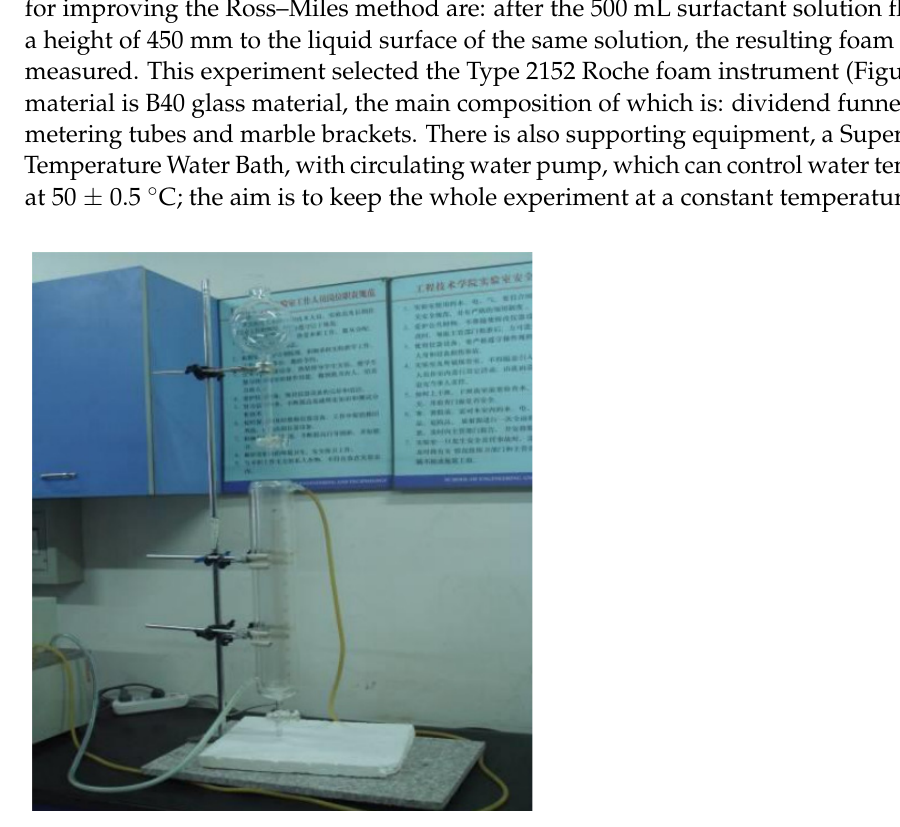
Figure 3. Physical diagram of the Type 2152 Roche foam instrument. (Improved